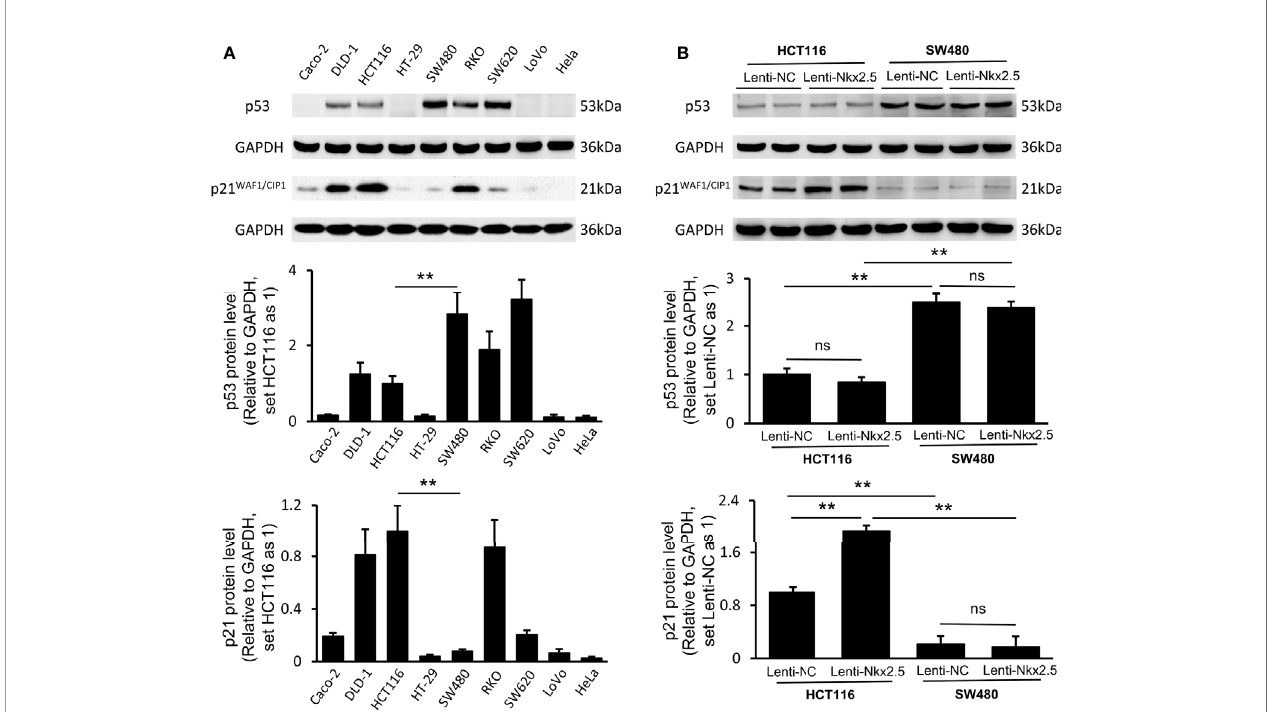
FIGURE 6 | Expression of p53 and p21 WAF1/CIP1 in CRC cell lines and Nkx2.5 overexpressed CRC cells. (A) Western blotting and RT-qPCR were employed for detecting protein levels of p53 and p21 WAF1/CIP1 in CRC cell lines. (B) Western blotting and RT-qPCR were used for detecting mRNA levels of p53 and p21 WAF1/CIP1 in Lenti-NC and Lenti-Nkx2.5 CRC cells. GAPDH was used as an endogenous control gene. ** represents P < 0.01; ns represents P ≥ 0.05 (no statistical signi fi